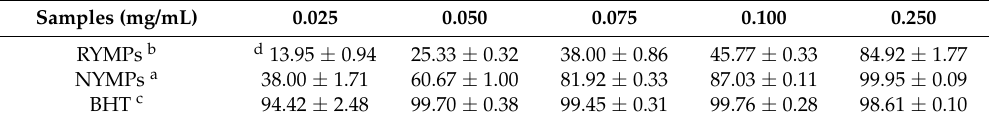
Table 2. e ABTS + radical scavenging activity of yellow Monascus pigments.